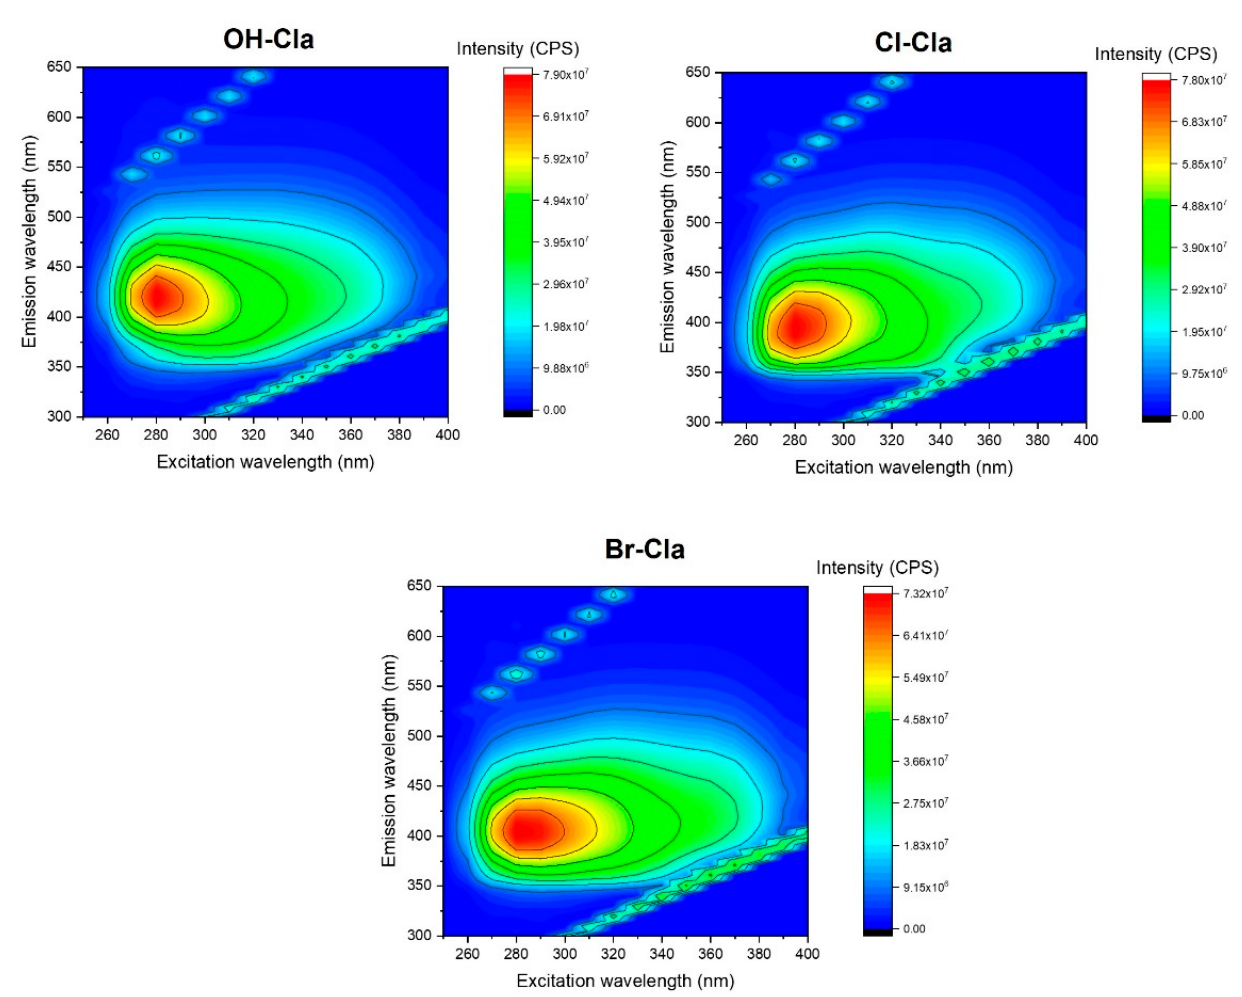
Figure 3. The 2D excitation-emission matrices (EEMs) of spent chemiluminescent reactions of OH-, Cl-, and Br-Cla after 30 min of reaction in DMSO-acetate buffer pH 5.14 (0.68%) solution.